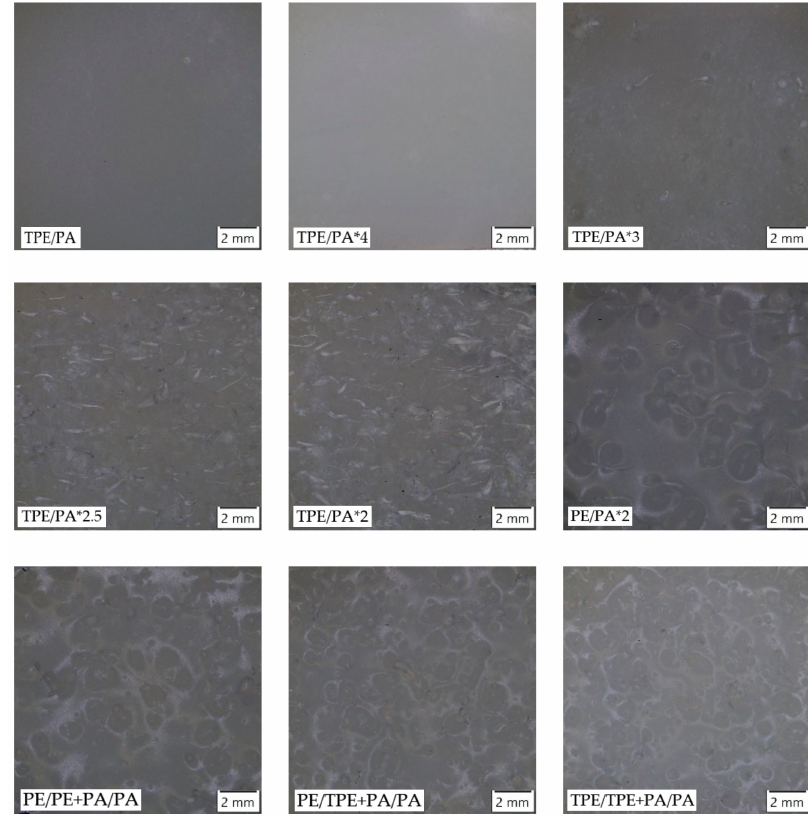
Figure 5. Micrographs of fracture surfaces.